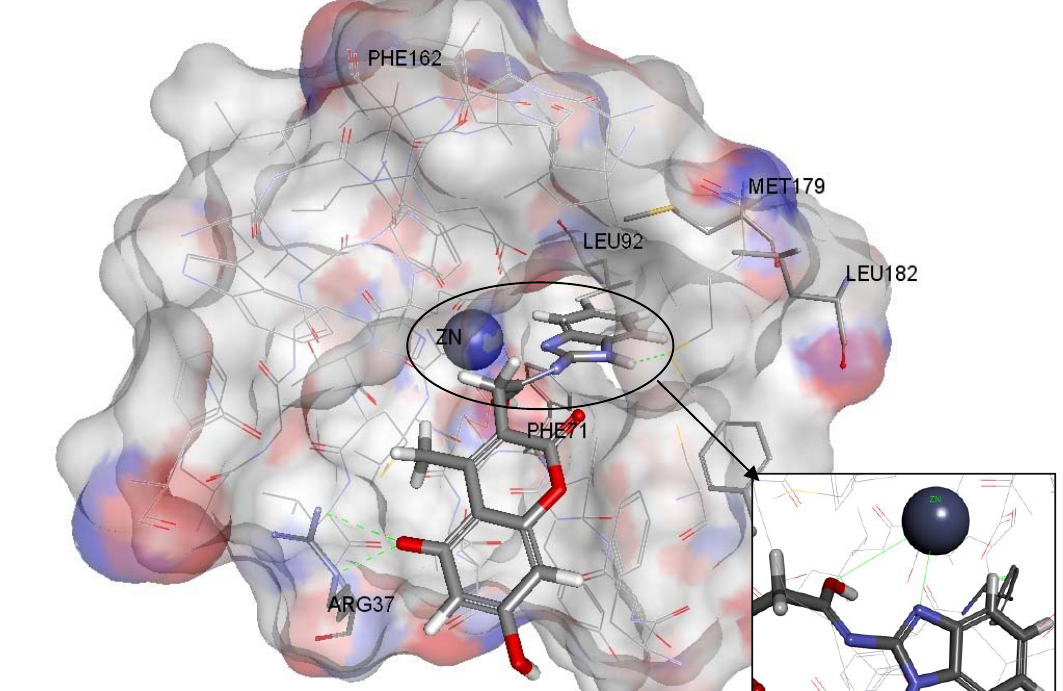
Figure 12. Zinc08791976 docked inside the Glo-1 active